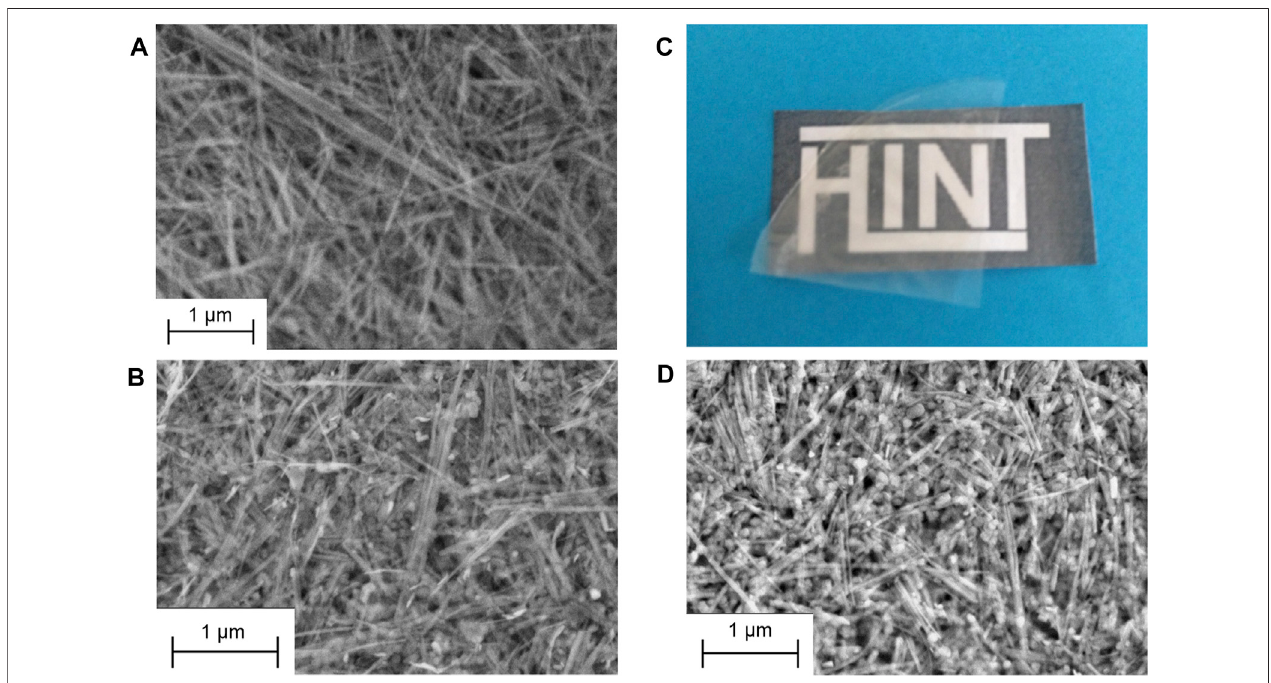
FIGURE 10 | FE-SEM images of SEP-LDH fi lms prepared with dispersions of the components at ratio of (A) 1:0 and (B) 1:1; and aspect of a fi lm obtained after casting and drying of a SEP-LDH/ALG 1:1:2 dispersion observed (C) at the eye and (D) by FE-SEM.